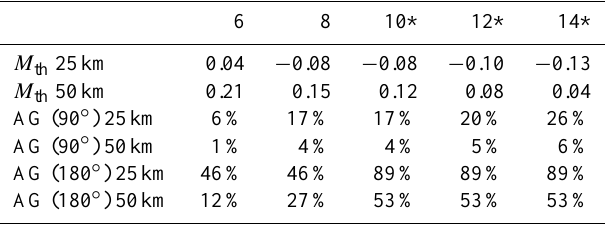
* Two island locations